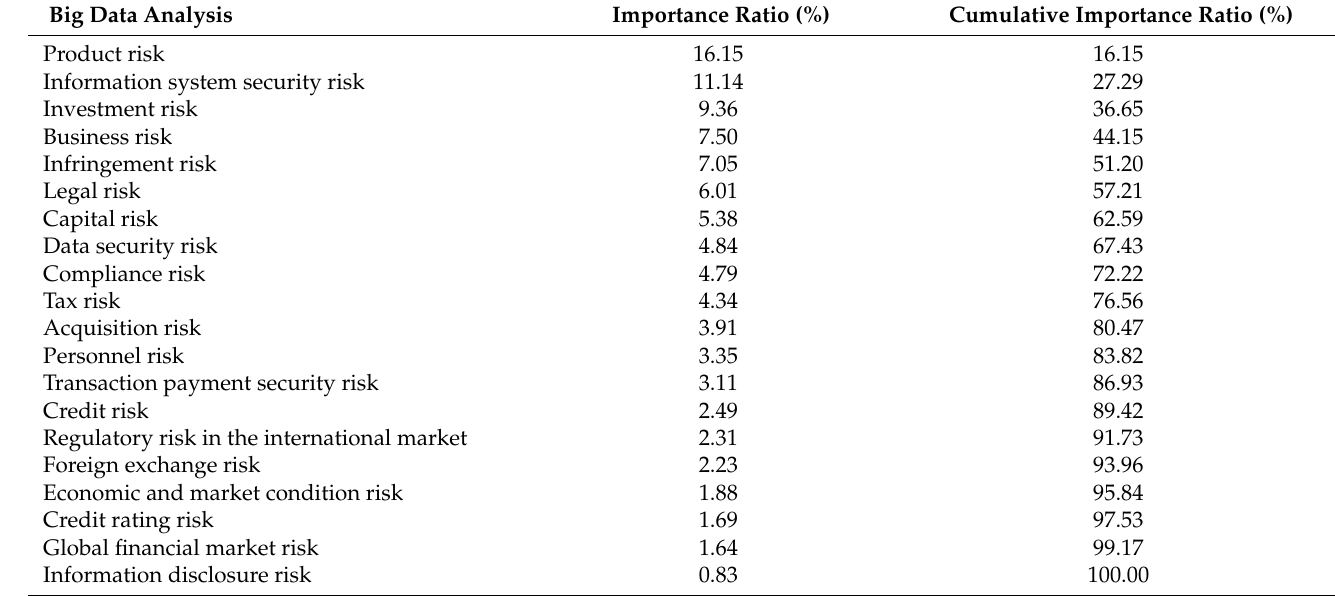
Table 7. The importance ratios of risks faced by the big data analysis industry from 2015 to